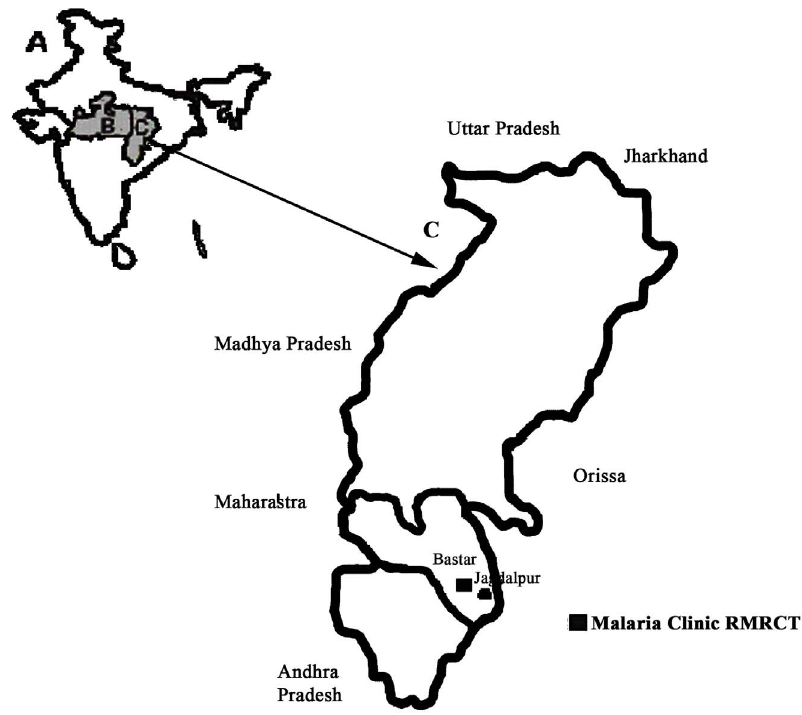
Fig. 1. Map of study site. The map shows India (A), state of Madhya Pradesh, where RMRCT is located in Jabalpur (B), state of Chhattisgarh (C). Malaria clinic of RMRCTat Maharani Hospital and associated Medical college Jagdalpur is shows in Bastar region in